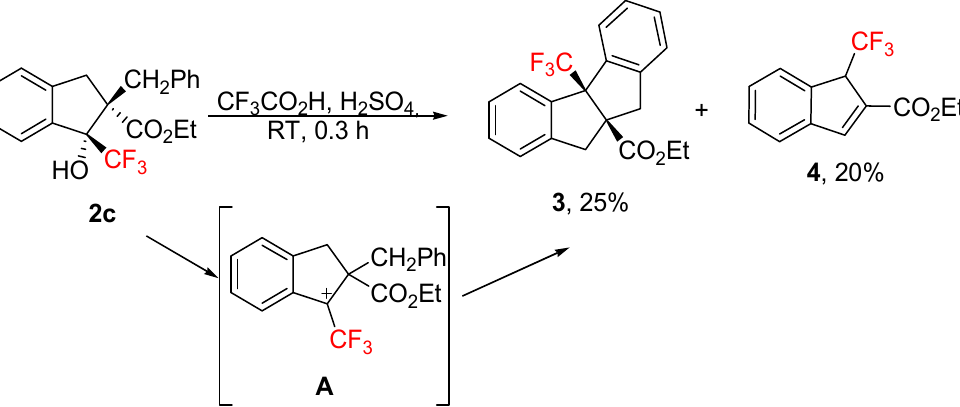
Scheme 3. Transformation of 1-CF 3 -indane 2c into compounds 3 and 4 in CF 3 CO 2 H, H 2 SO 4 .